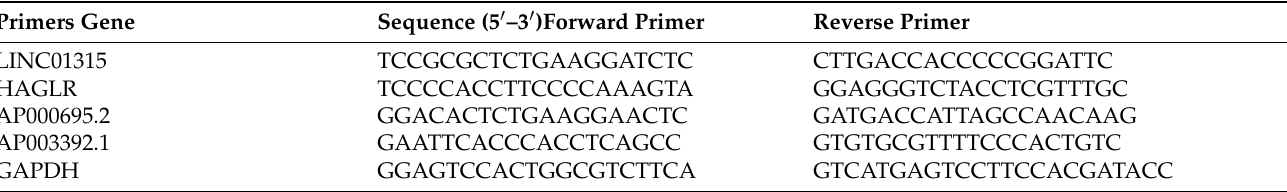
Table 1. The sequences of primers used in this